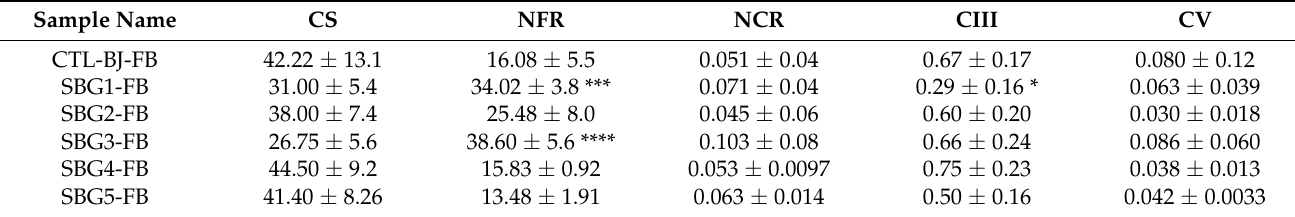
Table 3. Electron transport chain activity of CTL BJ-FB and five LS fibroblast cell lines. The electron transport chain activities for NFR (proximal part of CI), NCR (distal part of CI), CIII, CV of mitochondria isolated from control and diseased cells are normalized to citrate synthase activity measured in the same samples. Activities are expressed in nmol/mg protein/min/CS. Results are mean +/ − S.D, n = 3–5 for all individual disease lines, and n = 9 for the BJ-FB control cell line. NCR, NADH:cytochrome c oxidoreductase; NFR, NADH:ferricyanide oxidoreductase; CS, citrate synthase; CIII, cytochrome bc1; CV, ATP synthase. * p < 0.05 *** p < 0.001 **** p < 0.0001 vs.